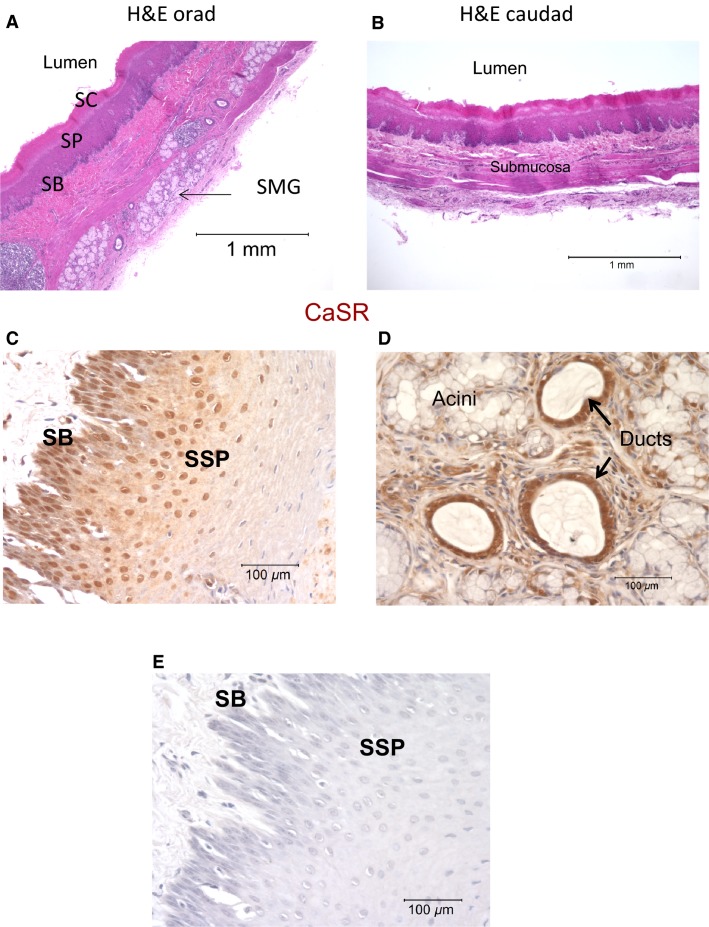
Porcine esophageal histology and CaSR expression by immunohistochemistry (A) Cross section from orad region of the pig esophagus stained with H&E showing submucosal glands (SMG); SB (stratum basalis), SSP (stratum spinosum), SC (stratum corneum). (B), Cross section from caudad region devoid of glands. (C), Immunostaining of CaSR (brown deposits) in the stratified squamous epithelium. CaSR is distributed in the basal and suprabasal layers. (D), shows staining for CaSR in submucosal glands and strong expression in the ducts. The experiment was repeated three times using tissues from three different pigs. (E) shows a tissue section where the primary antibody was omitted from the staining procedure.